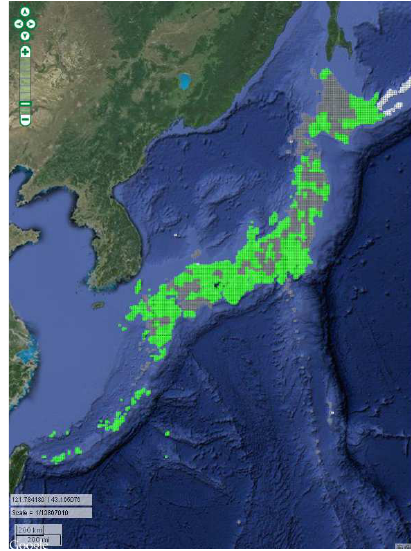
Figure 1. Area of Japan currently covered by National Survey of the Natural Environment 1/25,000 scale vegetation maps (green) (http://www.vegetation.biodic.go.jp)